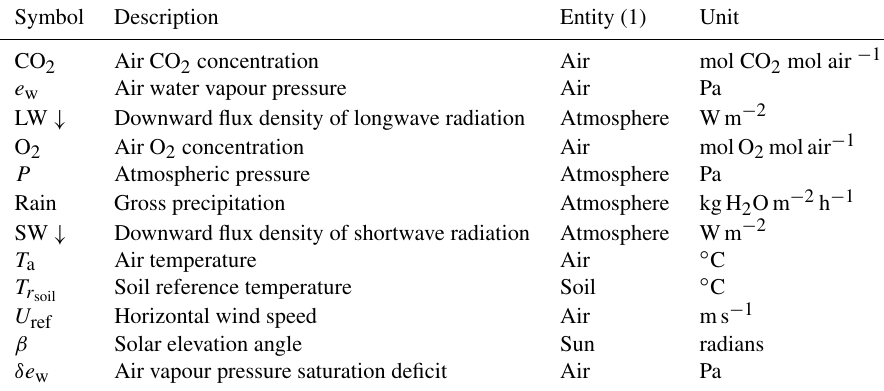
Table 1. List of the forcing meteorological variables driving the GO+ v3.0